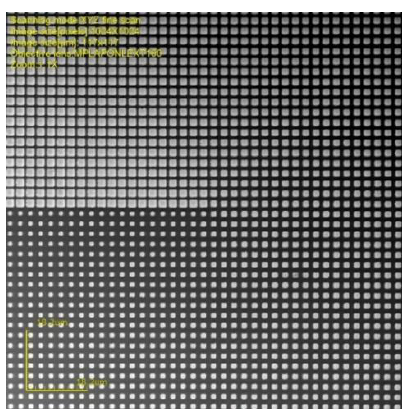
Figure 12. Intensity image of the phase mask taking using a Confocal Microscope.